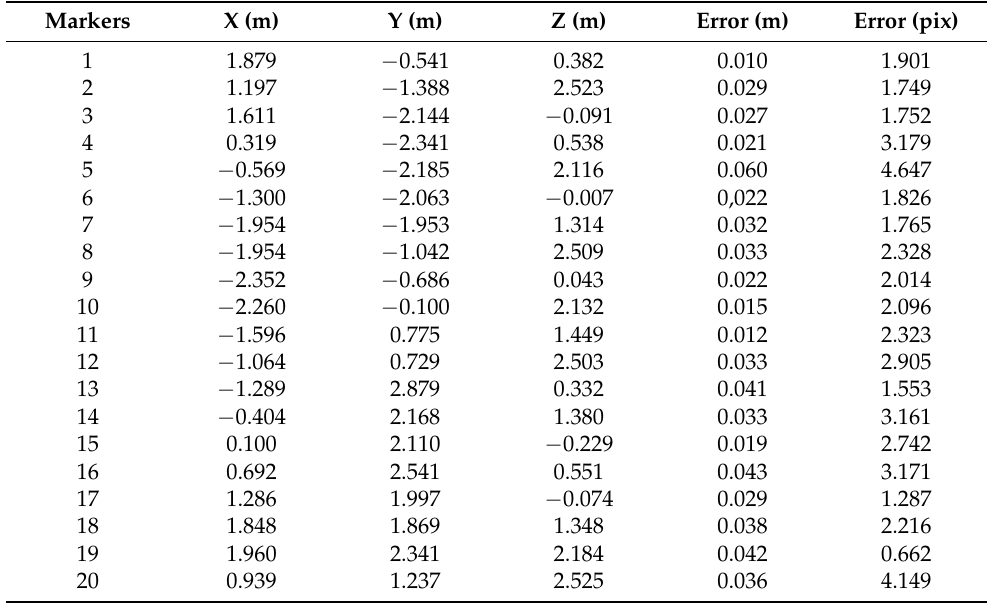
Table 3. Point coordinates (local system) obtained from TLS and estimation of photogrammetric errors. Markers X (m) Y